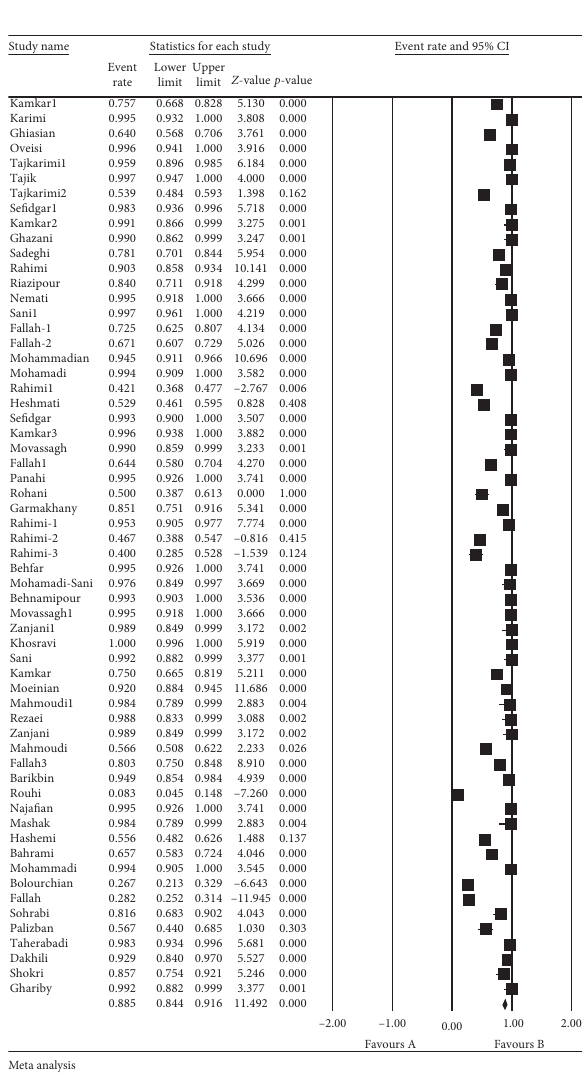
Figure 4: Prevalence of aflatoxin M1 in milk in Iran and 95% confidence